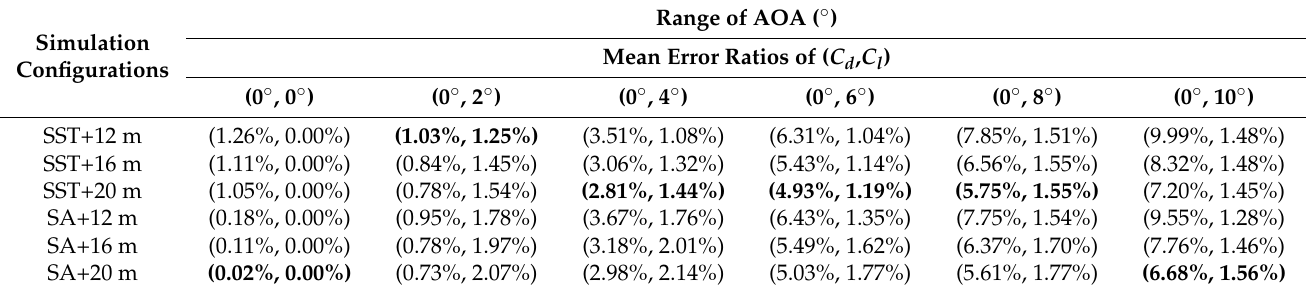
Table 10. The mean error ratios of C d and C l of the sharp trailing edge based on definition formula applying 132 points.